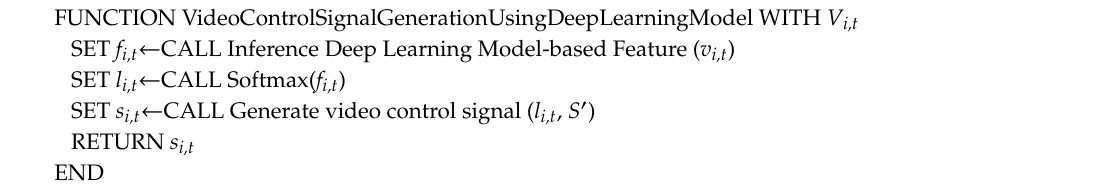
Algorithm 3 Pseudocode for generating 360-degree video control using trained deep learning model FUNCTION VideoControlSignalGenerationUsingDeepLearningModel WITH V i,t